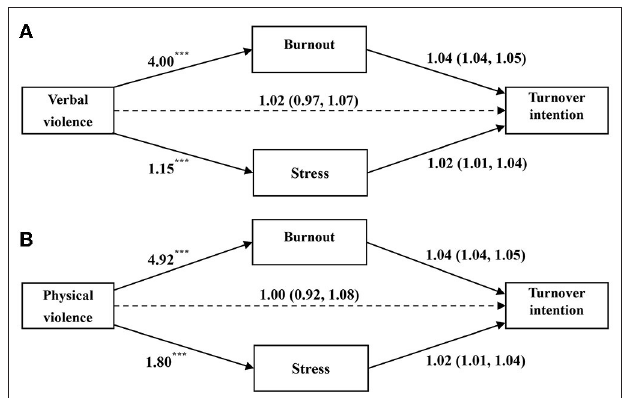
FIGURE 1 | Mediation effects of mental health between WPV and turnover intention. (A) illustrates the path coefficients of the relationship between verbal violence and turnover intention; (B) of the relationship between physical violence and turnover intention. Regression coefficients are shown for the path from WPV to burnout and stress, * p < 0.05; ** p < 0.01; *** p < 0.001. ORs and corresponding 95% CI (in parentheses) are shown for the path between mental health and turnover intention, which is measured as a binary variable. Both models adjusted for age, gender, education, working years, income, working hours per week, self-rated health.